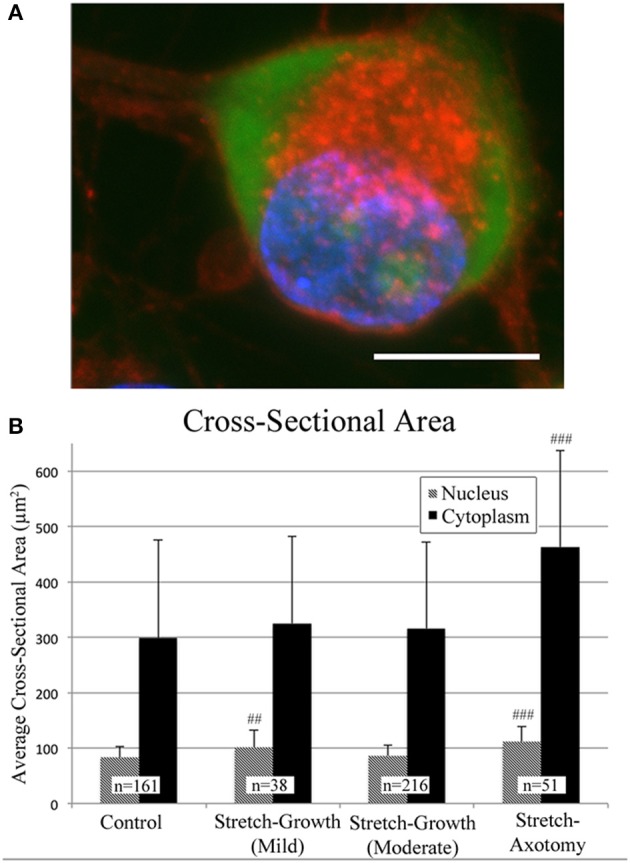
Morphological analysis of soma following axon stretch. (A) Example of a DRG neuron as stained for analysis using wheat germ agglutinin (red), Nissl stain (green), and DAPI (blue); bar = 10 μm. (B) Mild and moderate stretch-growth paradigms resulted in normal cytoplasmic cross-sectional areas. Stretch-axotomized neurons had significantly larger cytoplasms and nuclei compared to controls (p < 0.0001 for cytoplasms and nuclei). ‘##’ and ‘###’ indicate p < 0.005 and p < 0.0005, respectively, compared to controls.